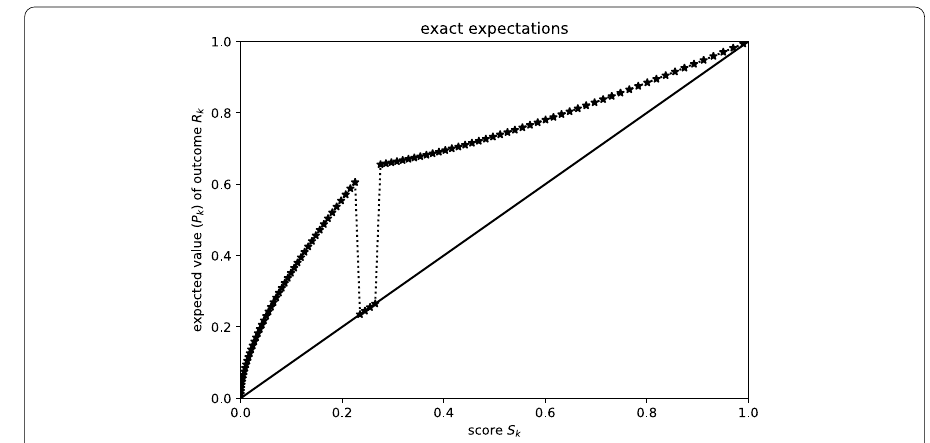
Fig. 39 Ground-truth reliability diagram for Figure 38